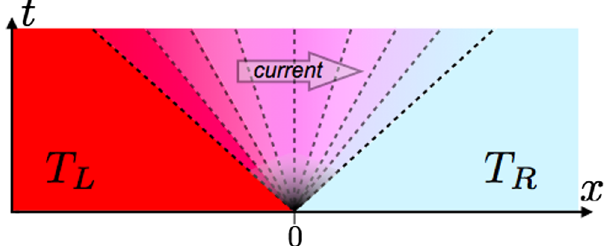
FIG. 1. The partitioning protocol. With ballistic transport, a current emerges after a transient period. Dotted lines represent different values of ξ ¼ x=t . If a maximal velocity exists (e.g., due to the Lieb-Robinson bound), initial reservoirs are unaffected beyond it (light-cone effect). The steady state lies at ξ ¼ 0